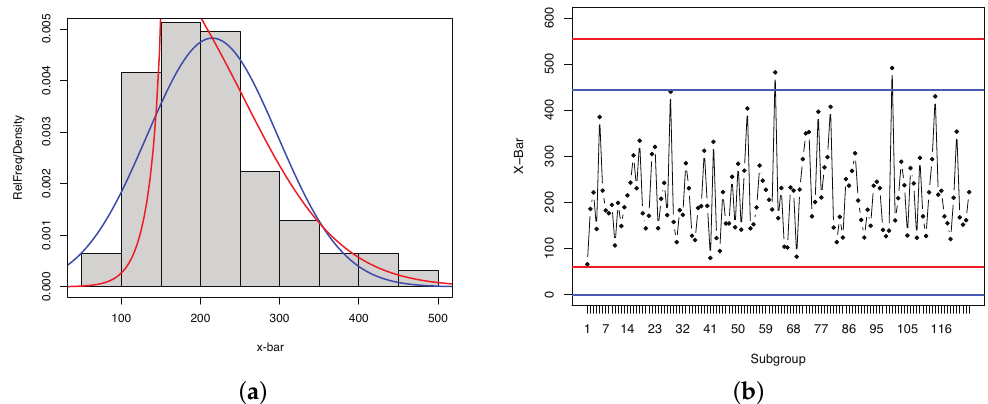
Figure 1. ( a ) Histogram of 125 subgroup means of size n = 4 corresponding to m = 500 pre-samples from a lognormal ( µ = 5.1, σ = 0.75 ) distributed process with approximate Gaussian and fourth re-expressed density functions fitted with sample cumulants. ( b ) Corresponding ¯ X -chart displaying subgroups means and approximate control limits. Gaussian (blue) and re-expressed fourth (red) approximations. Sampled data consist of m = 500 data points, yielding 125 subgroups means of size n =